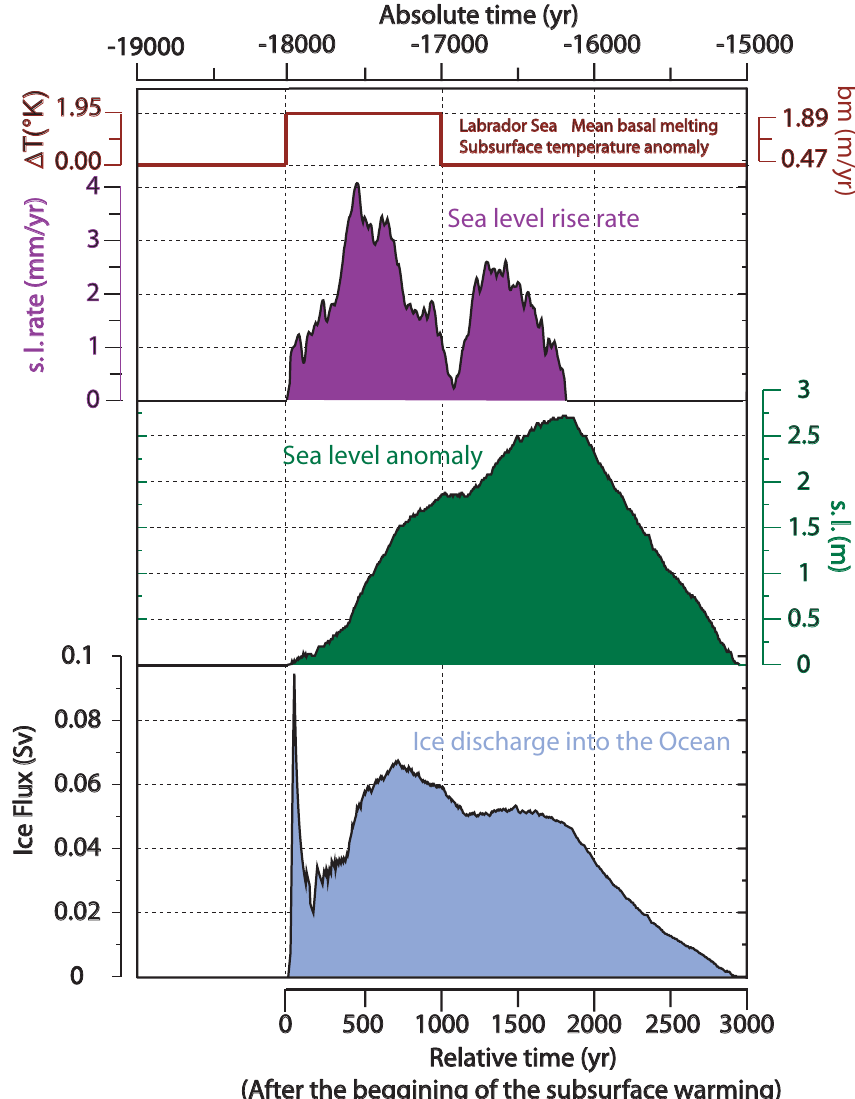
(After the beggining of the subsurface warming) Fig. 4. Labrador Sea subsurface temperature anomaly (in K) and basal melting (in myr − 1 ; red curve), sea level rise rate (in mmyr − 1 ), sea level rise (m) and iceberg calving (in Sv) derived from the effects of the oceanic subsurface warming on the dynamic behavior of the Laurentide ice